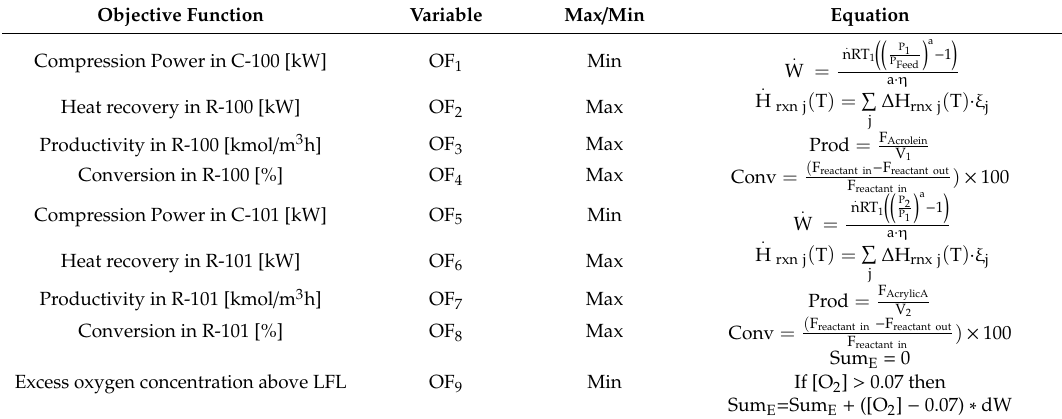
Table 1. Objective functions for the multi-objective optimization (MOO) of the acrylic acid production process.